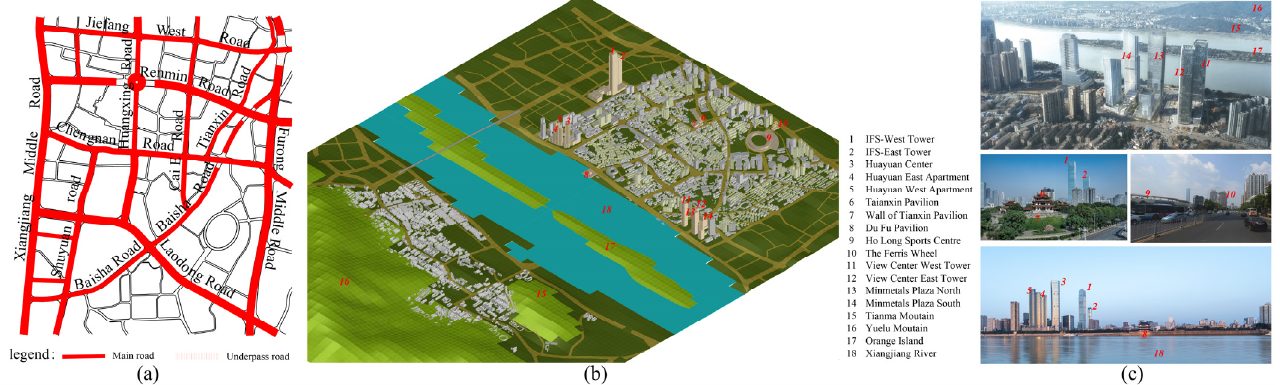
Figure 9. TP-District. ( a ) Regional road network, ( b ) 3D geometric model of the district, as well as the surrounding environment, ( c ) Photographs and partial renderings of landmarks.